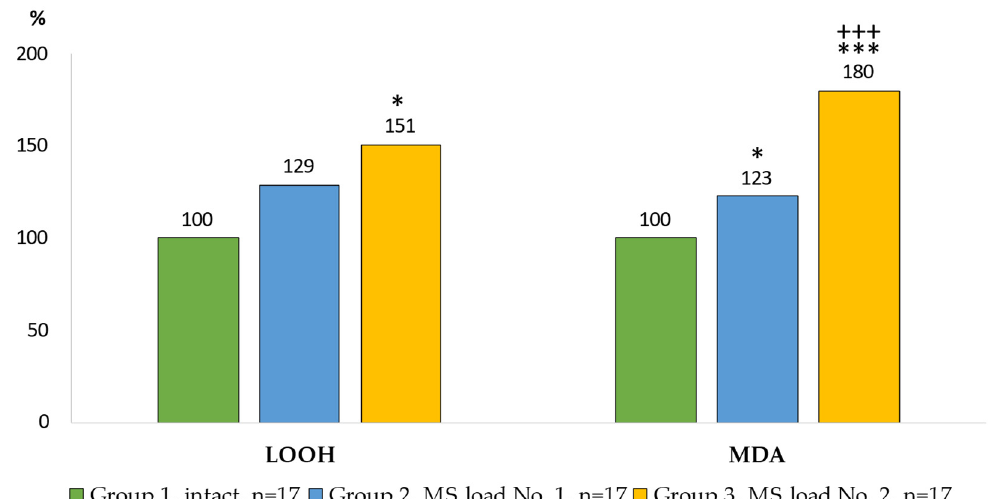
Figure 2. Indicators of lipid peroxidation in the AM culture. Notes: statistical significance relative to Group 1: *— p < 0.05; ***— p < 0.001; relative to Group 2: +++— p < 0.001.